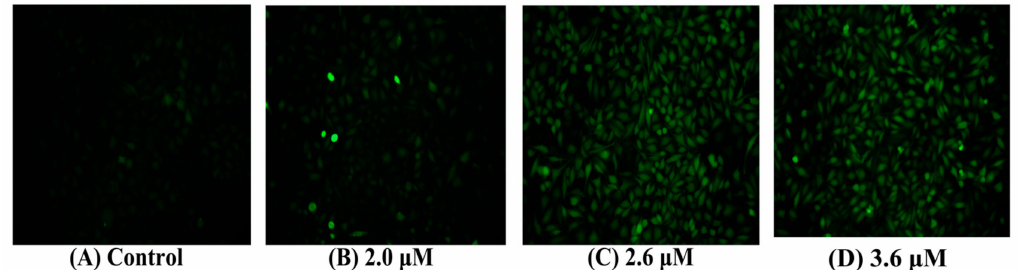
Figure 10. The ROS generation assay of MGC80-3 cells treated with complex 1 (2.0, 2.6, and 3.6 µ M), and the cells were examined under a fluorescence microscope (Nikon Te2000, 200 × ).